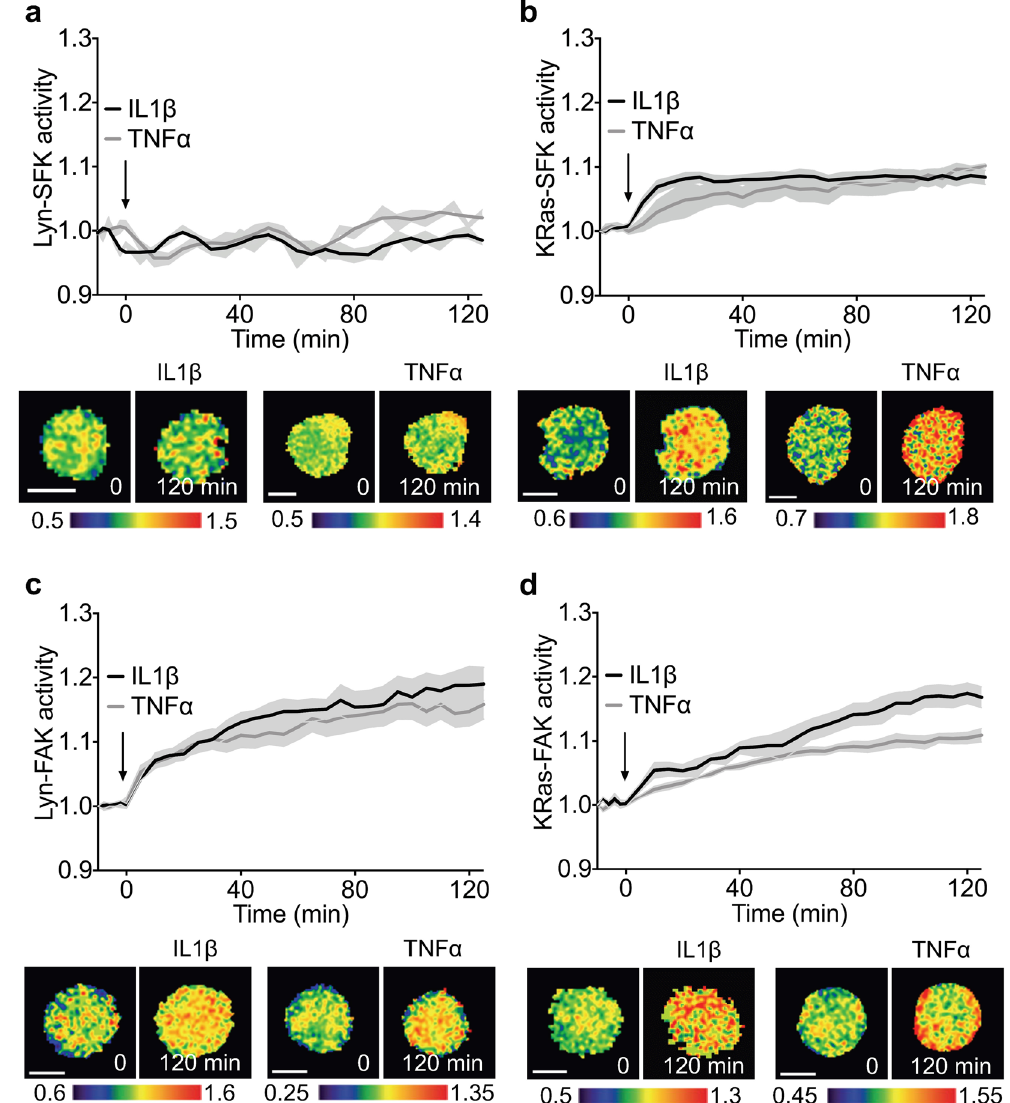
Figure 3. Subcellular domain-dependent activities of SFK and FAK under IL1 β and TNF α . Cells transfected with one of the FRET biosensors were imaged under treatment of either 1 ng/ml IL1 β or 10 ng/ml TNF α . ( a ) Lyn-SFK activities ( n = 6 in IL1 β , n = 6 in TNF α ). ( b ) KRas-SFK activities ( n = 7 in IL1 β , n = 6 in TNF α ). ( c ) Lyn-FAK activities ( n = 6 in IL1 β , n = 6 in TNF α ). ( d ) KRas-FAK activities ( n = 6 in IL1 β , n = 6 in TNF α ). Time courses represent normalized FRET ratios of the biosensors under the cytokine. The representative FRET ratio images were scaled according to the color bar. Scale bars, 10 μ